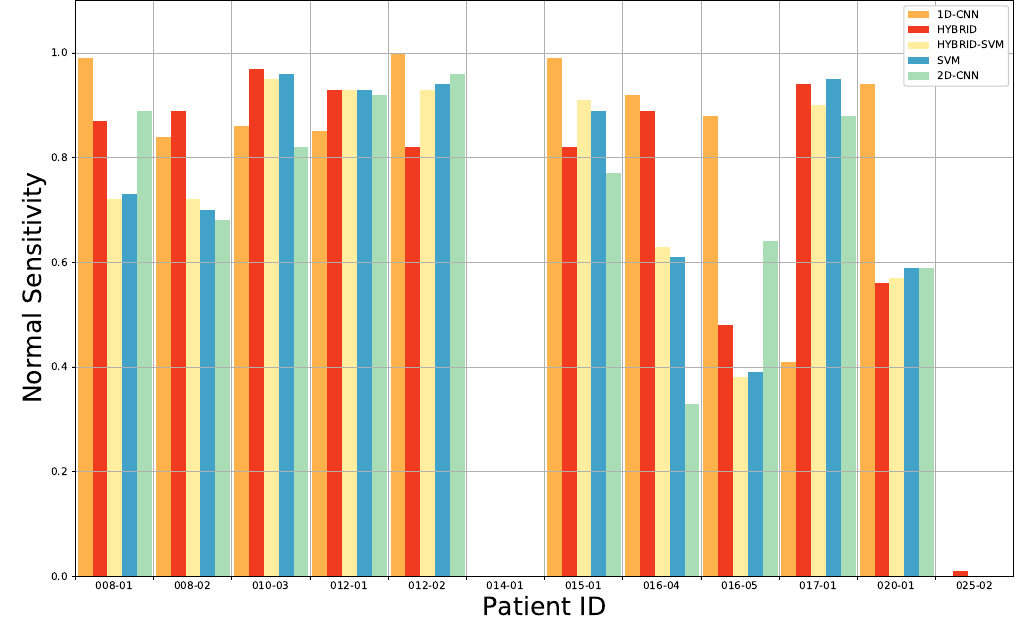
Figure 5. Average sensitivity results for the normal tissue classification of the leave-one-patient-out cross-validation of the four-class classification for each method: 1D CNN, 3D–2D hybrid CNN, 3D–2D hybrid CNN + SVM, the SVM and the 2D